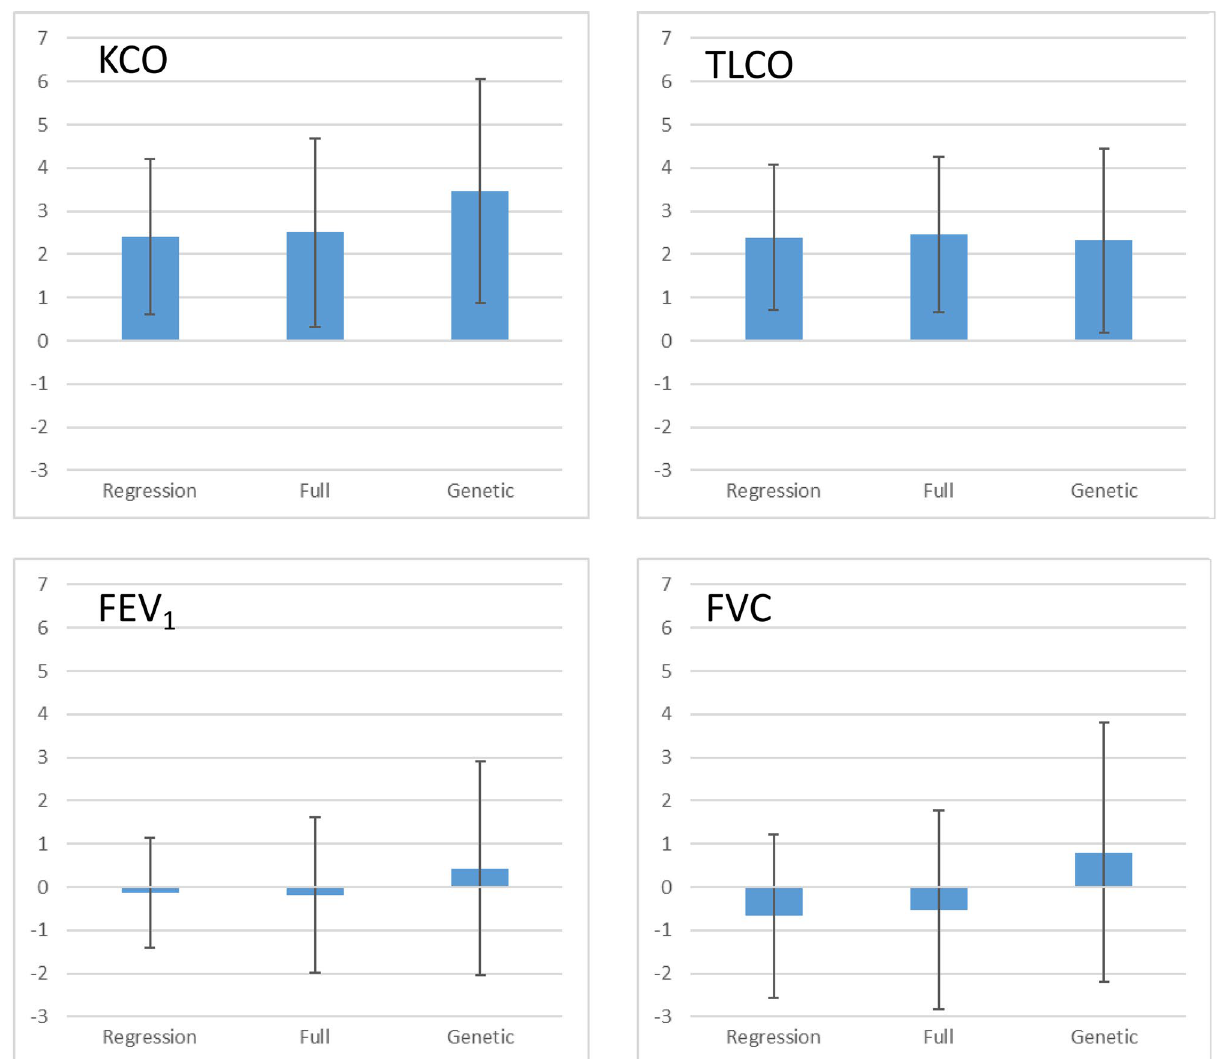
Figure 2. Association of metformin with annual changes in lung function (mean and 95%-confidence intervals). The four panels refer to KCO, TLCO, FEV 1 and FVC, and the changes on the vertical axes are expressed as percent predicted at baseline. Positive values mean that the fall of the lung function measure (negative change) is reduced by the respective amount compared to the non-metformin group. Each panel shows three estimated effects, first from the regression analyses, then from the propensity score analyses using either full or genetic matching. As can be seen, the results were similar within each lung function measure and the pattern of statistically significant vs non-significant effects was the same. In addition, indicators for collinearity are given. Results for any metformin therapy as well as for TLCO were similar (see “Results” section and Tables S1, S2,